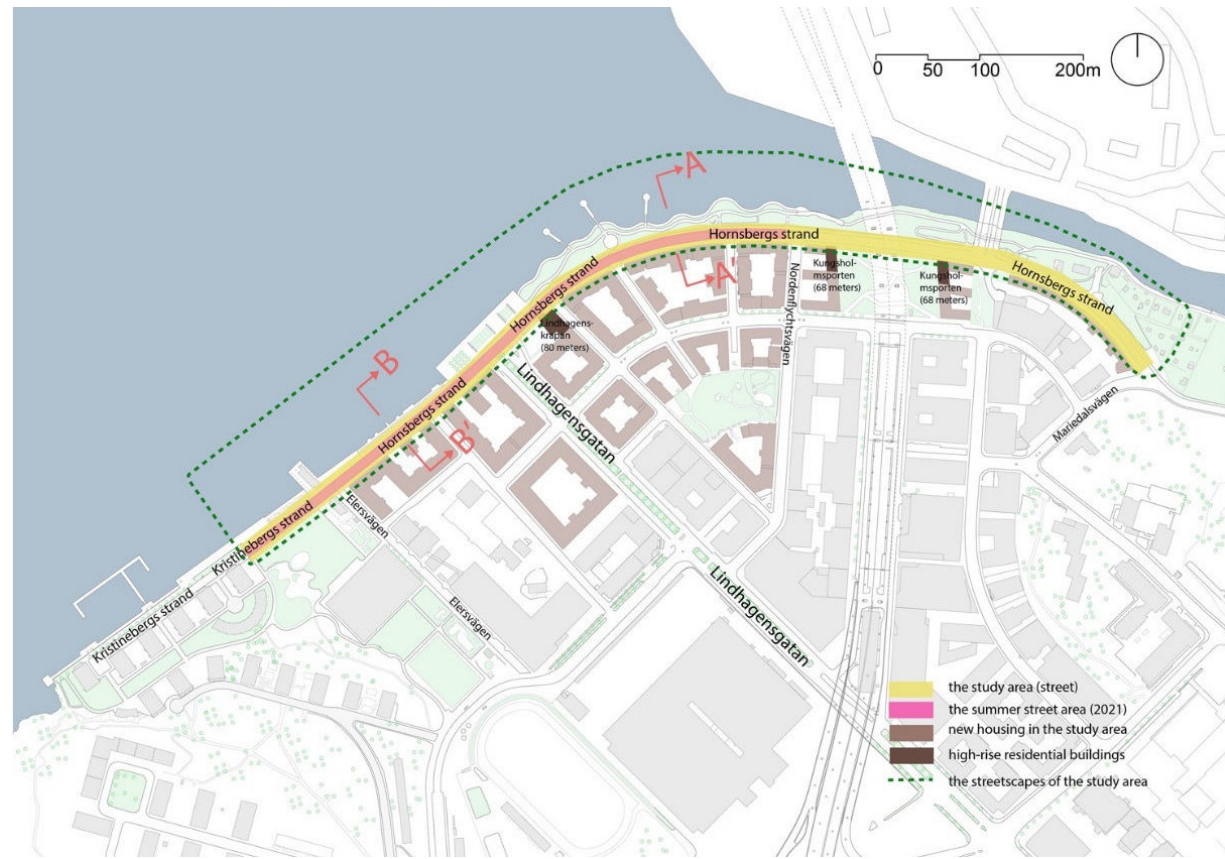
Figure 1. The case study area: HBS, Stockholm. Source: Author’s and Gaudy Orejuela’s work. Urban Planning, 2022, Volume 7, Issue 4, Pages